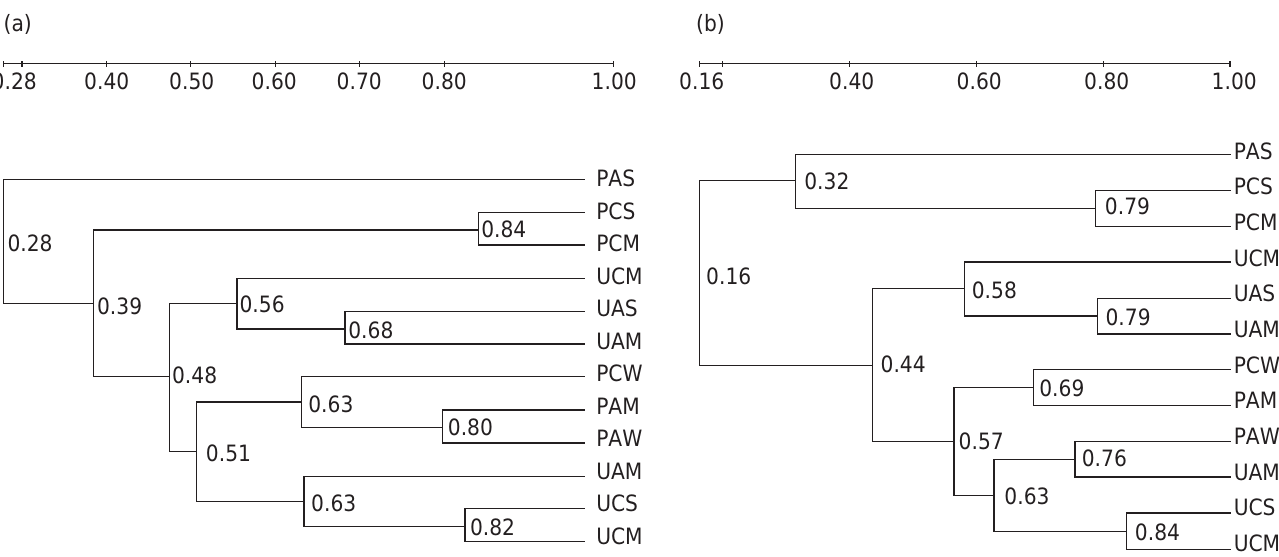
Figure 2. Dendrogram constructed with the complete similarity linkage between bacteria-specific (a) and fungi-specific (b) PCR-DGGE patterns for different treatments. UAW: unplanted treatment with ambient CO 2 and well-watered condition; UAM: unplanted treatment with ambient CO 2 and mild drought condition; UAS: unplanted treatment with ambient CO 2 and severe drought condition; PAW: planted treatment with ambient CO 2 and well-watered condition; PAM: planted treatment with ambient CO 2 and mild drought condition; PAS: planted treatment with ambient CO 2 and severe drought condition; UCW: unplanted treatment with elevated CO 2 and well-watered condition; UCM: unplanted treatment with elevated CO 2 and mild drought condition; UCS: unplanted treatment with elevated CO 2 and severe drought condition; PCW: planted treatment with elevated CO 2 and well-watered condition; PCM: planted treatment with elevated CO 2 and mild drought condition; PCS: planted treatment with elevated CO 2 and severe drought